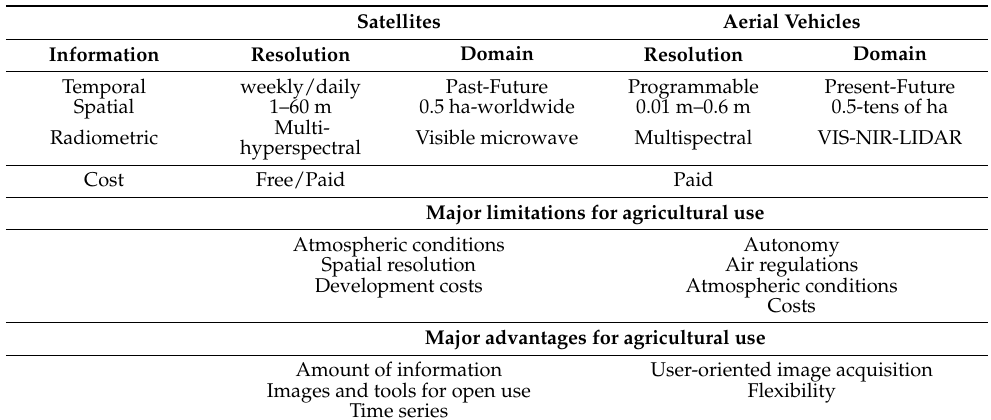
Table 1. Summary of the agricultural use potentialities of remote sensing using satellites and drones equipped with multi and hyperspectral sensors or